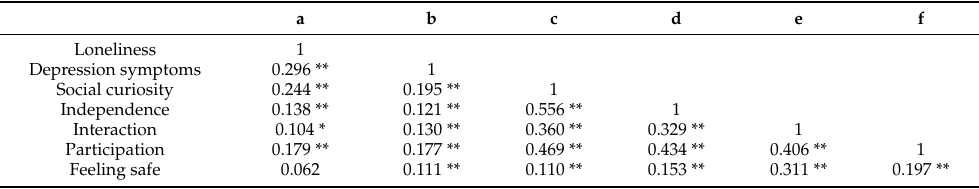
Table 2. Intercorrelations among loneliness, depression symptoms, and social relationships (N = 555).